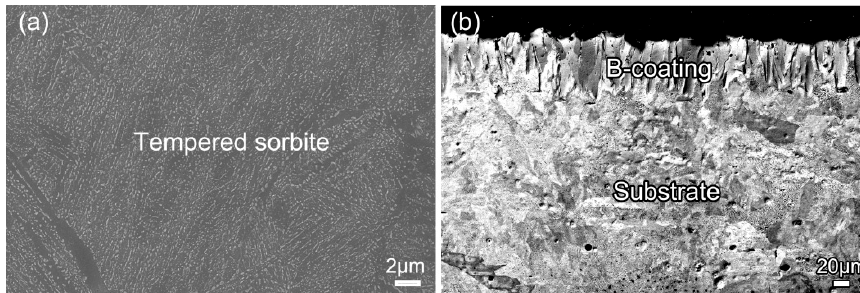
Figure 2. Secondary electron imaging (SEI) and backscattering electron imaging (BSEI) images showing the microstructure of the starting material ( a ) and PB sample ( b ).